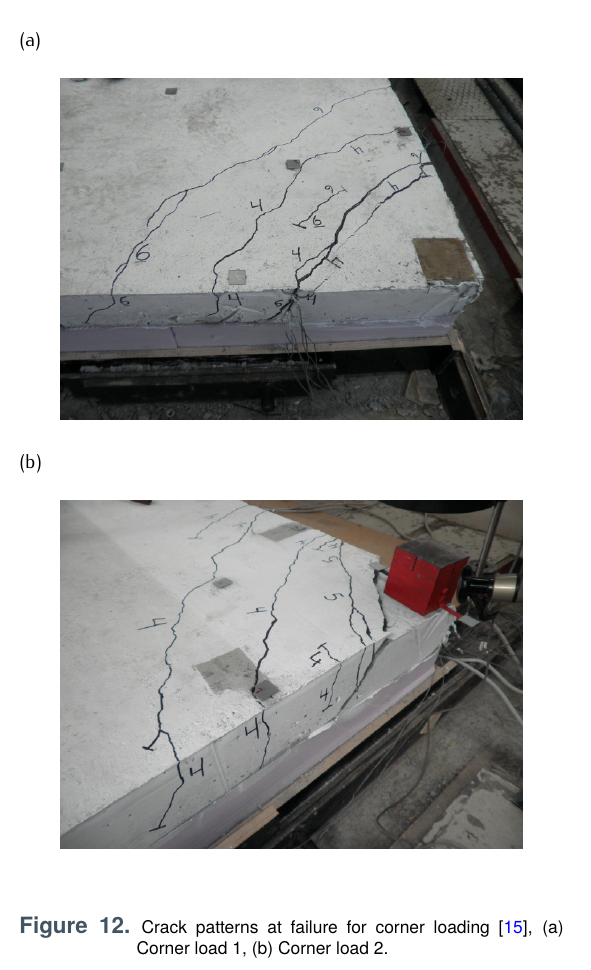
Figure 12. Crack patterns at failure for corner loading [15], (a) Corner load 1, (b) Corner load 2.